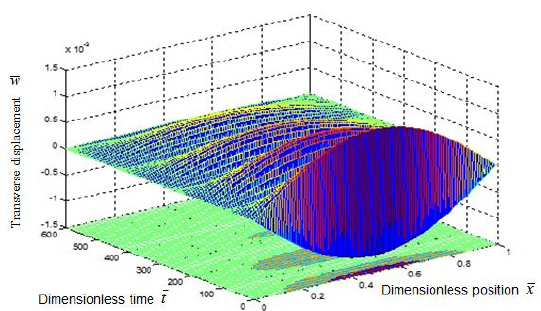
Figure 11. Dynamic response of the transverse displacement profile for the case R i = 0 . 41 m,γ = 0 . 02 ,n = 1 ,δ